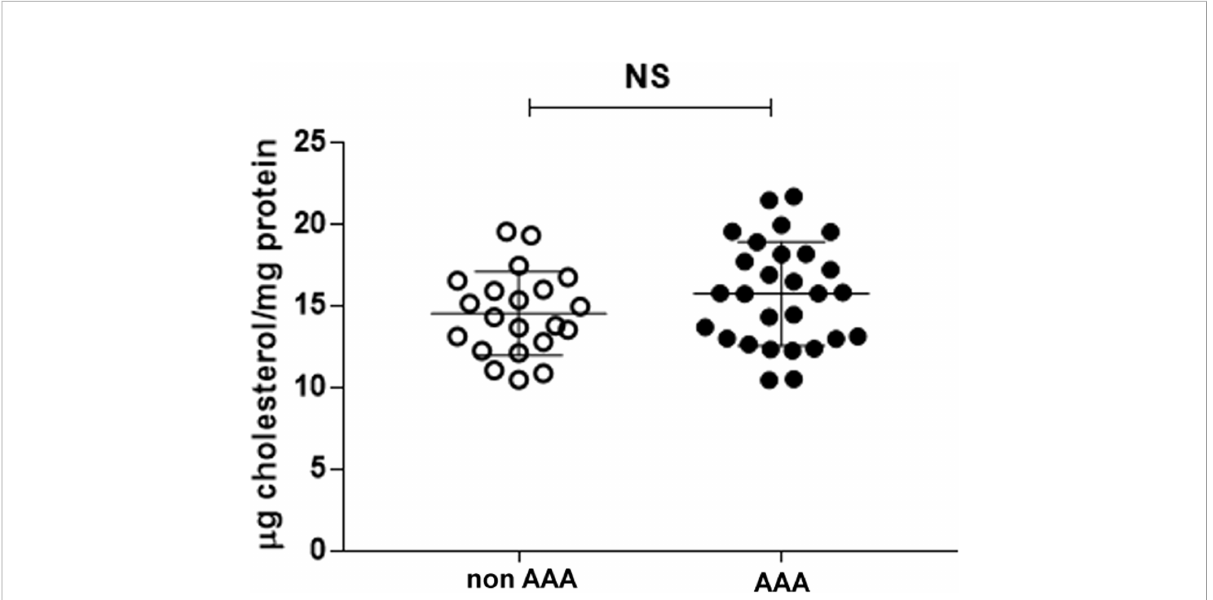
FIGURE 6 Serum CLC in AAA and non-AAA control patients. The mean and SD for each group are reported. The unpaired two-tailed Student ’ s t-test was applied. NS, not signi fi